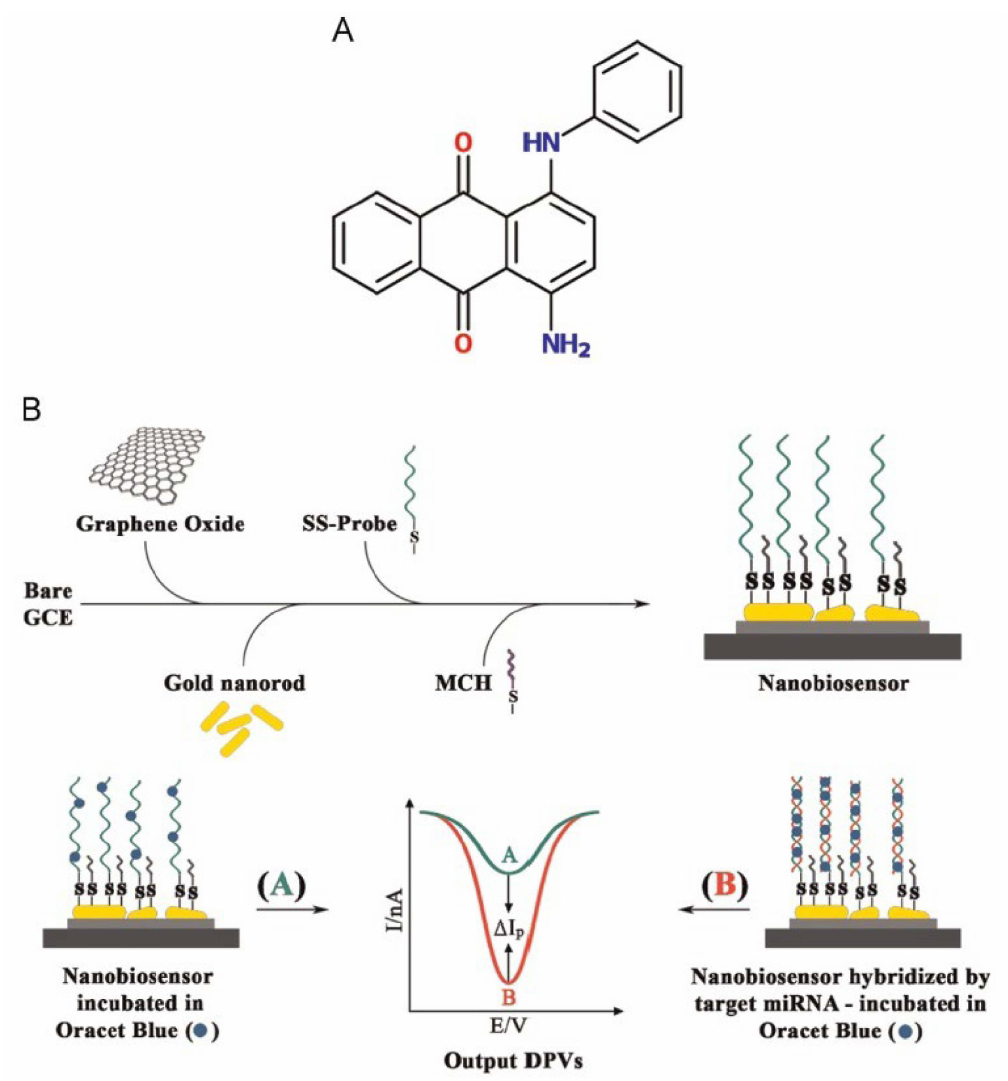
Figure 4. ( A ) Chemical structure of the Oracet Blue indicator. ( B ) Schematic representation of the process steps of the surface modification and working procedure of the electrochemical nanobiosen- sor developed for miR-155 determination. Reprinted with permission from Ref. [86]. Copyright 2016,